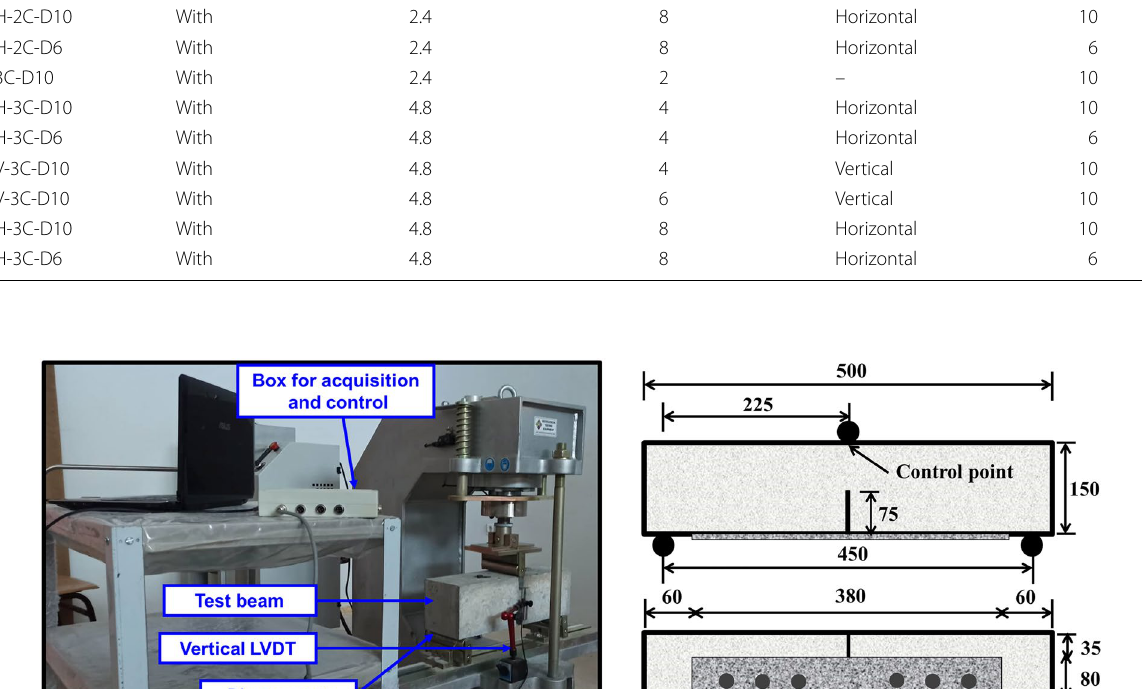
simultaneously anchoring plates remain attached to the bolts. This attachment allows the beams to resist new loads. With an increase in the applied load, a great diameter pressure on the bolts is developed, which leads to crashing in the GFRP plate after the second peak load. As a result, the load capacity decreases, and deflection increases until the typical ductile